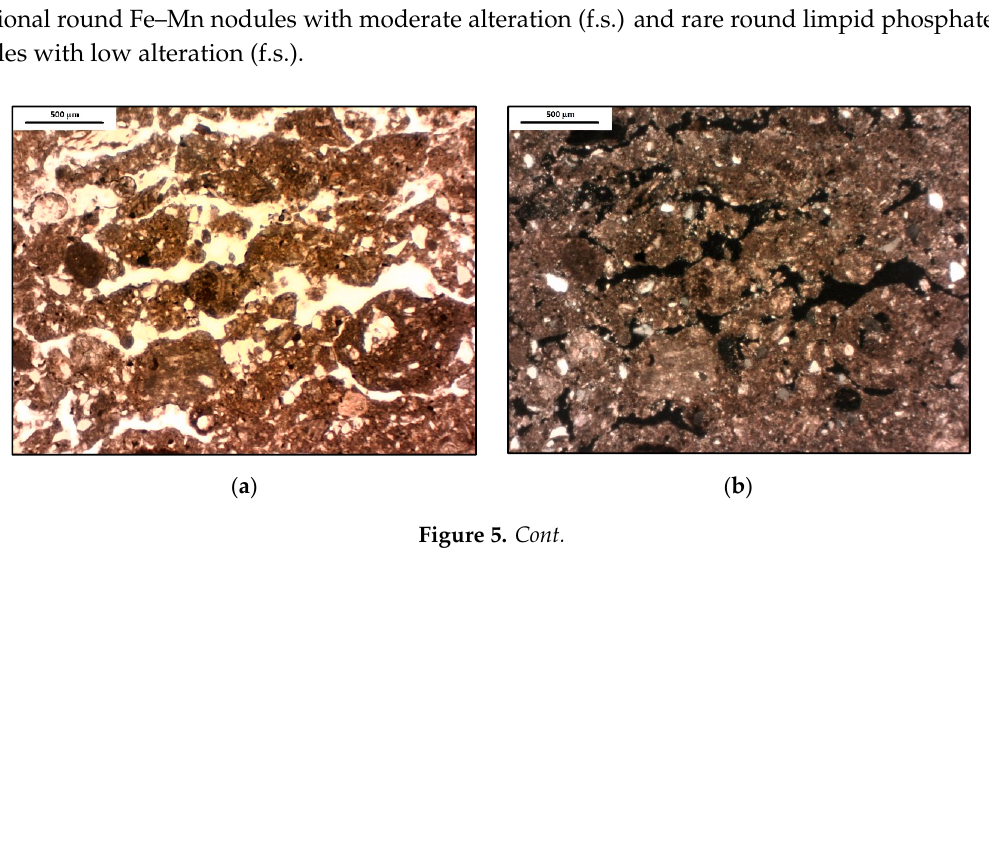
Figure 4. Sampling in the first part ( a ) and in the middle of the cave ( b